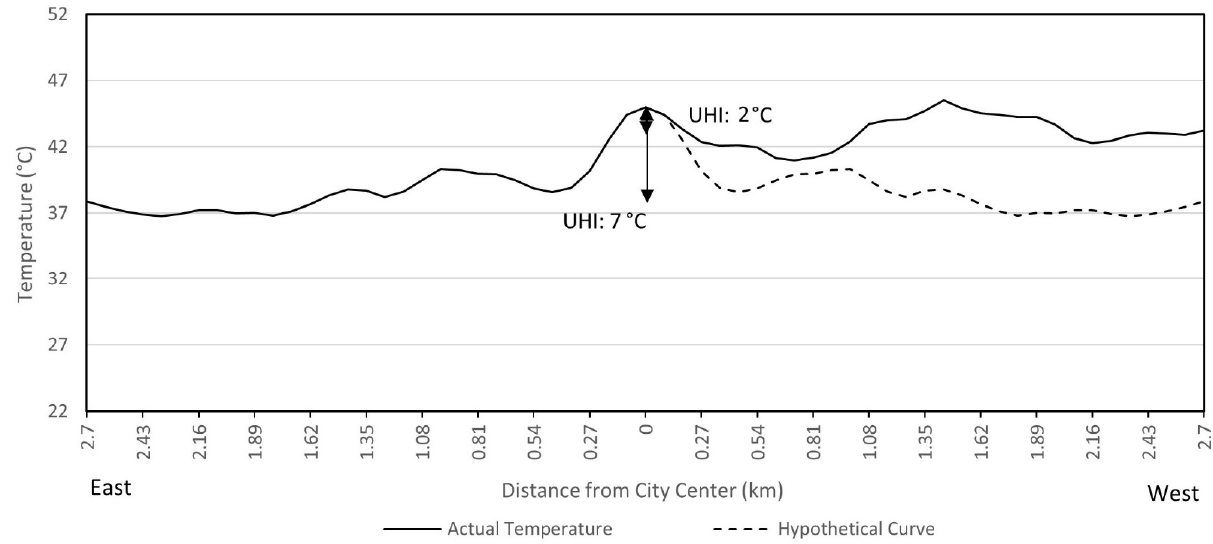
Figure 10. Surface temperature cross section along an east-west transect across the city of Ifrane.